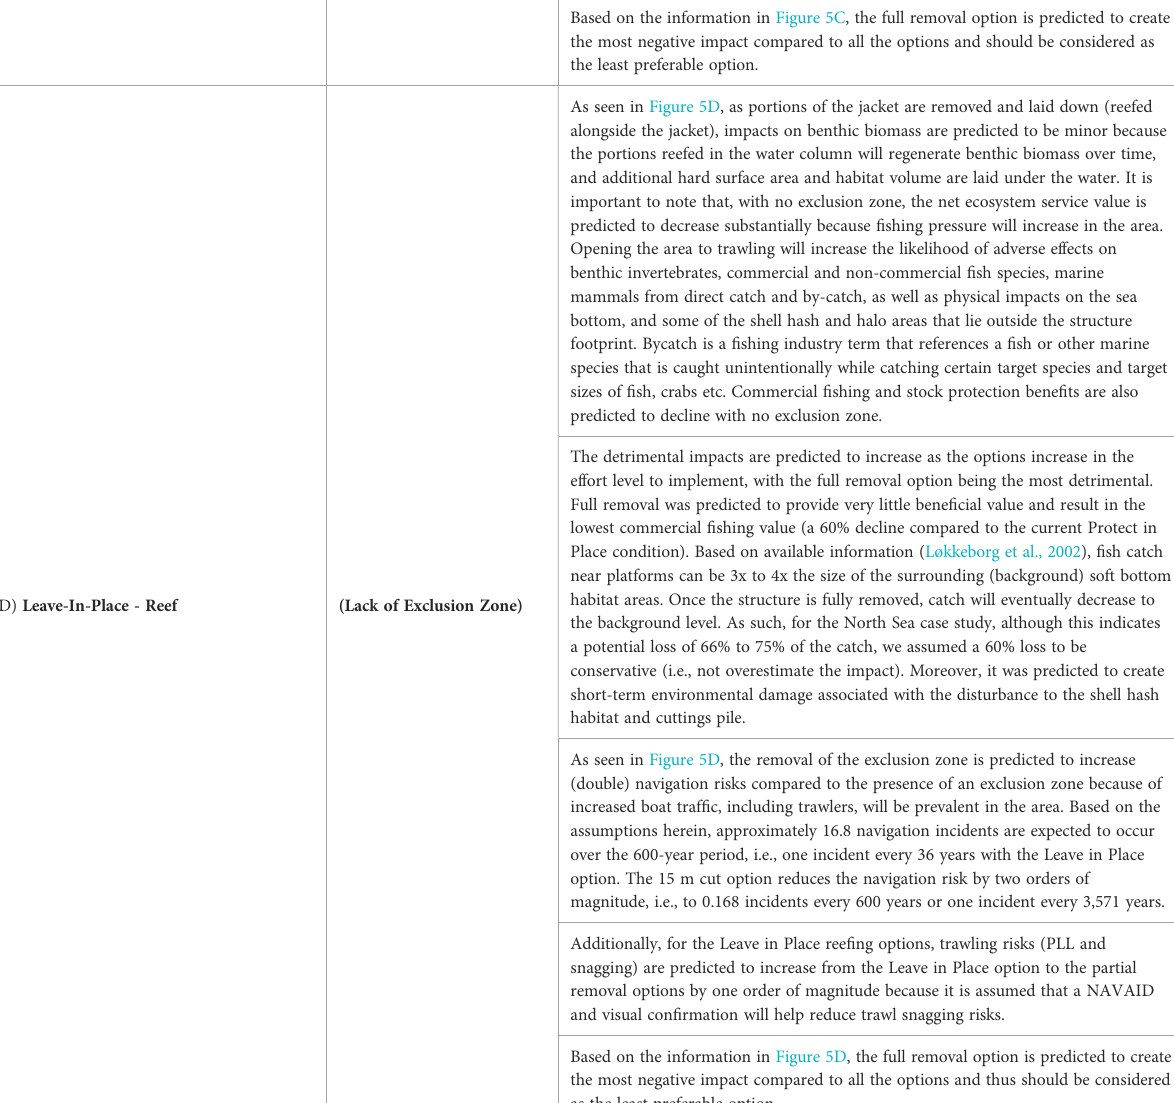
the least preferable